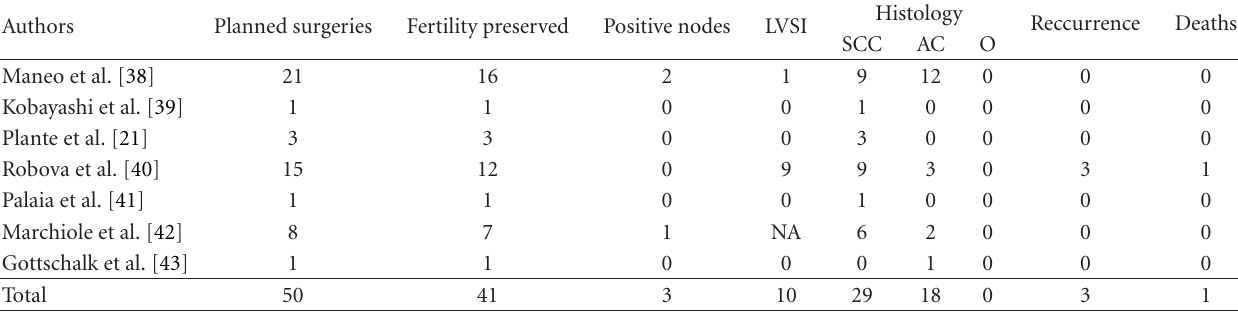
Table 8: Characteristics and oncological outcomes for fertility-sparing surgery after neoadjuvant chemotherapy.